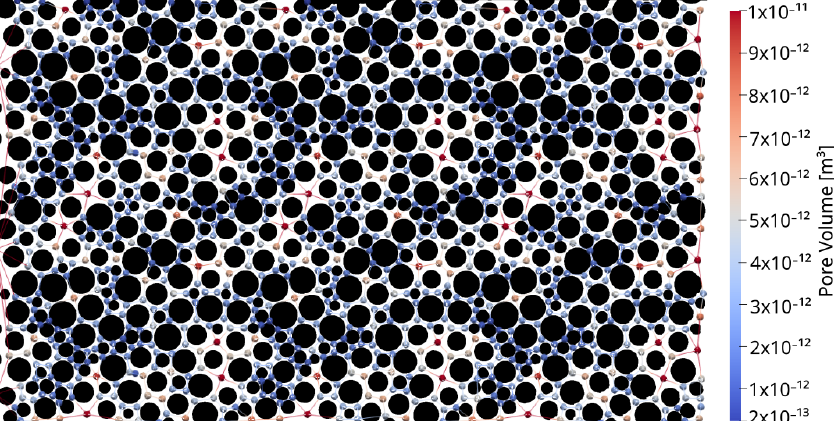
Figure 5. Extracted pore network showing the determined pore volumes overlayed over the mi- croscopy image.